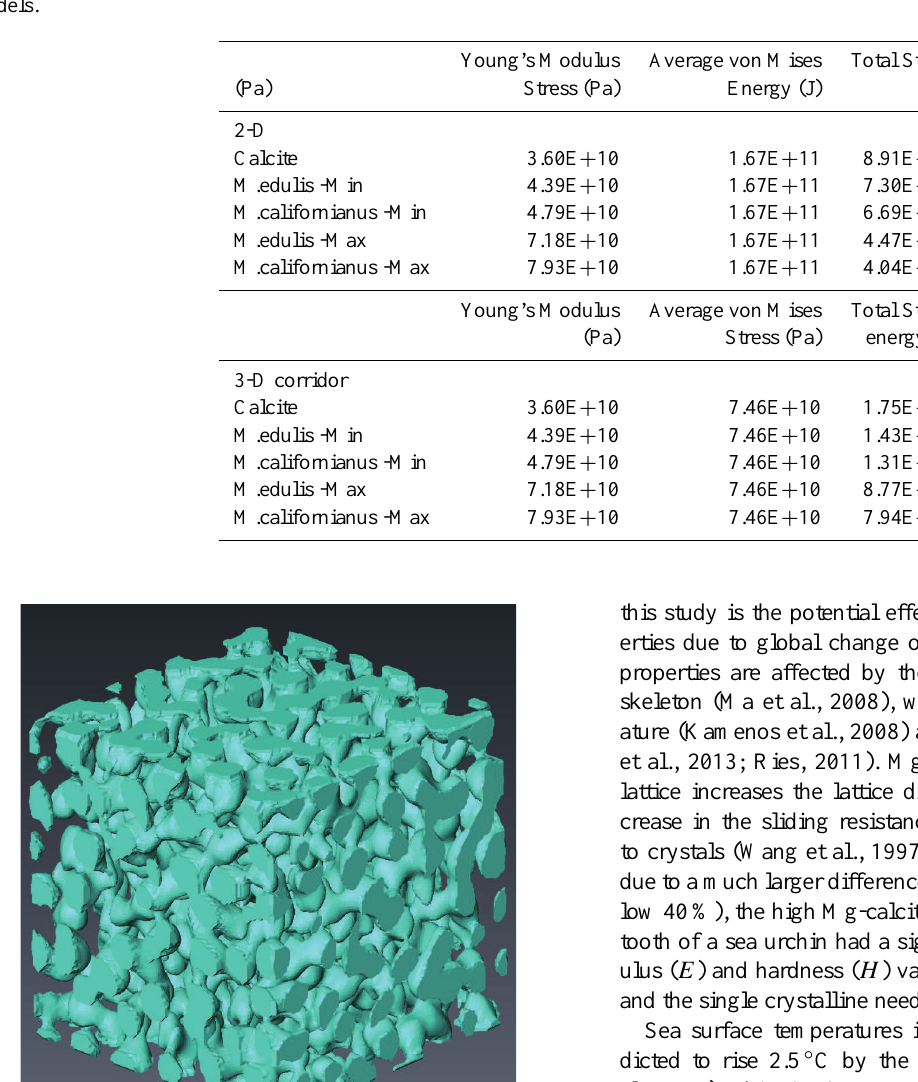
Table 4. Average von Mises stress and total strain energy for the comparison of the different material properties in the 2-D and 3-D corridor models.